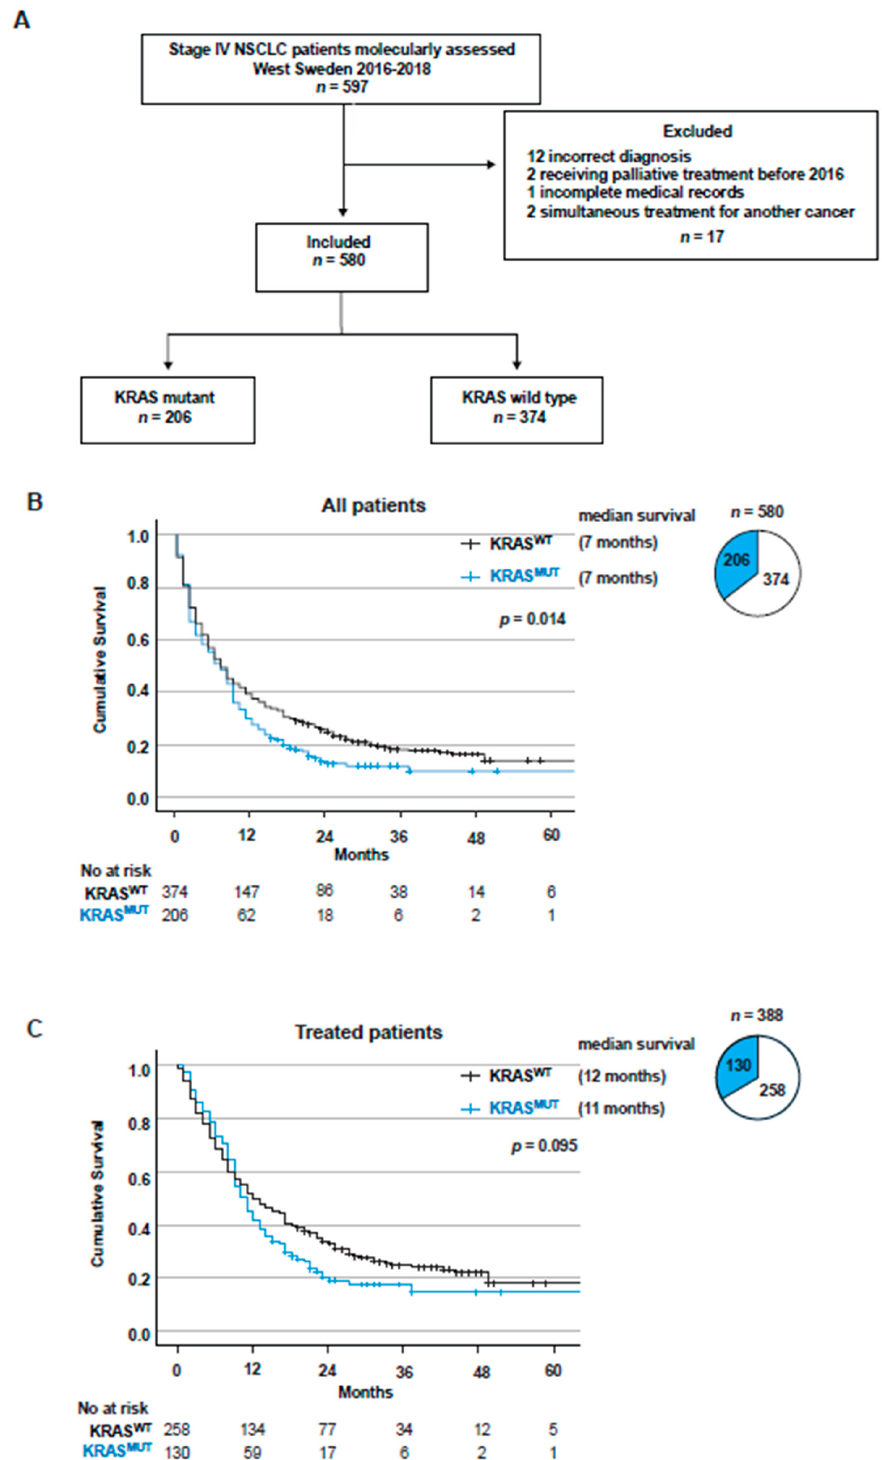
Figure 1. KRAS mutations are a negative factor for overall survival. ( A ) Flow chart showing the patient selection for the study. ( B ) Kaplan–Meier estimates comparing overall survival and median survival stratified on KRAS WT vs. KRAS MUT for the full cohort ( n = 580). Pie chart showing patient distribution between KRAS WT and KRAS MUT . ( C ) Kaplan–Meier estimates comparing overall survival for all receiving life-extending treatment (no treatment and only palliative radiotherapy excluded) stratified on KRAS WT vs. KRAS MUT . Pie chart showing patient distribution between KRAS WT and KRAS MUT .